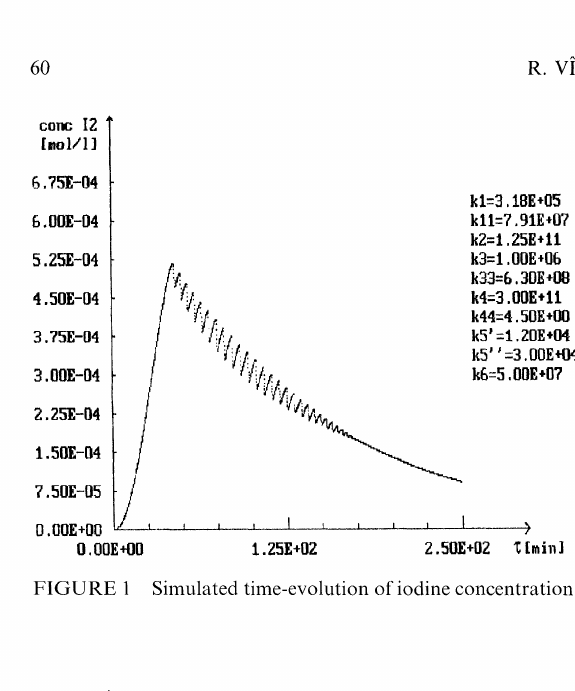
Simulated time-evolution of iodine concentration.